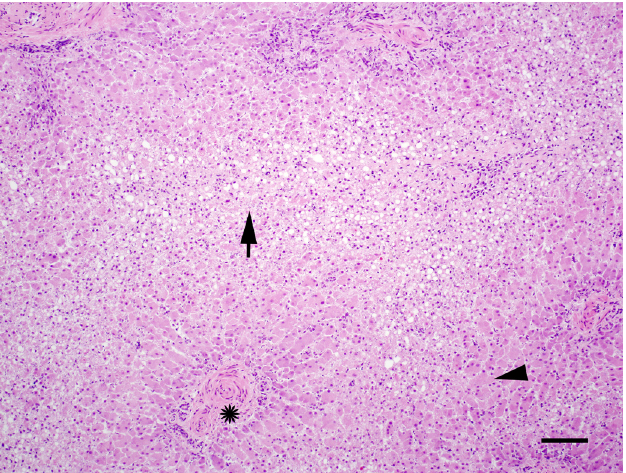
Fig 4. Hematoxylin and eosin (HE) stained section of liver from a juvenile dolphin that stranded fresh dead in Barataria Bay in July 2012. There is severe centrilobular hepatocellular vacuolation, necrosis, and loss with lobular collapse (arrow). Star indicates a portal triad. Arrow head indicates unaffected liver parenchyma for comparison. Bar = 500 μ